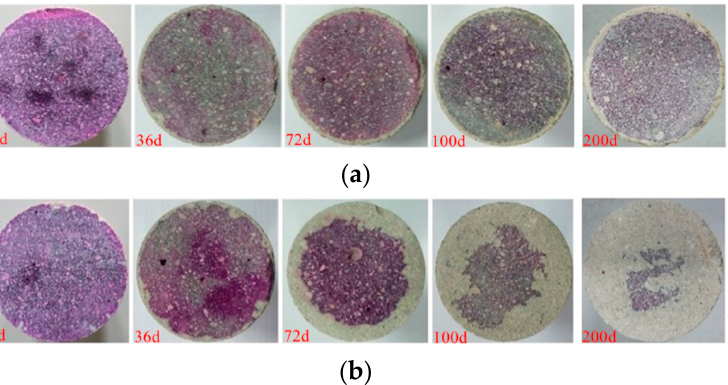
Figure 6. Carbonation depth measurements: ( a ) Group WB (water-immersion environment) and ( b ) Group HA (saturated-humidity environment).